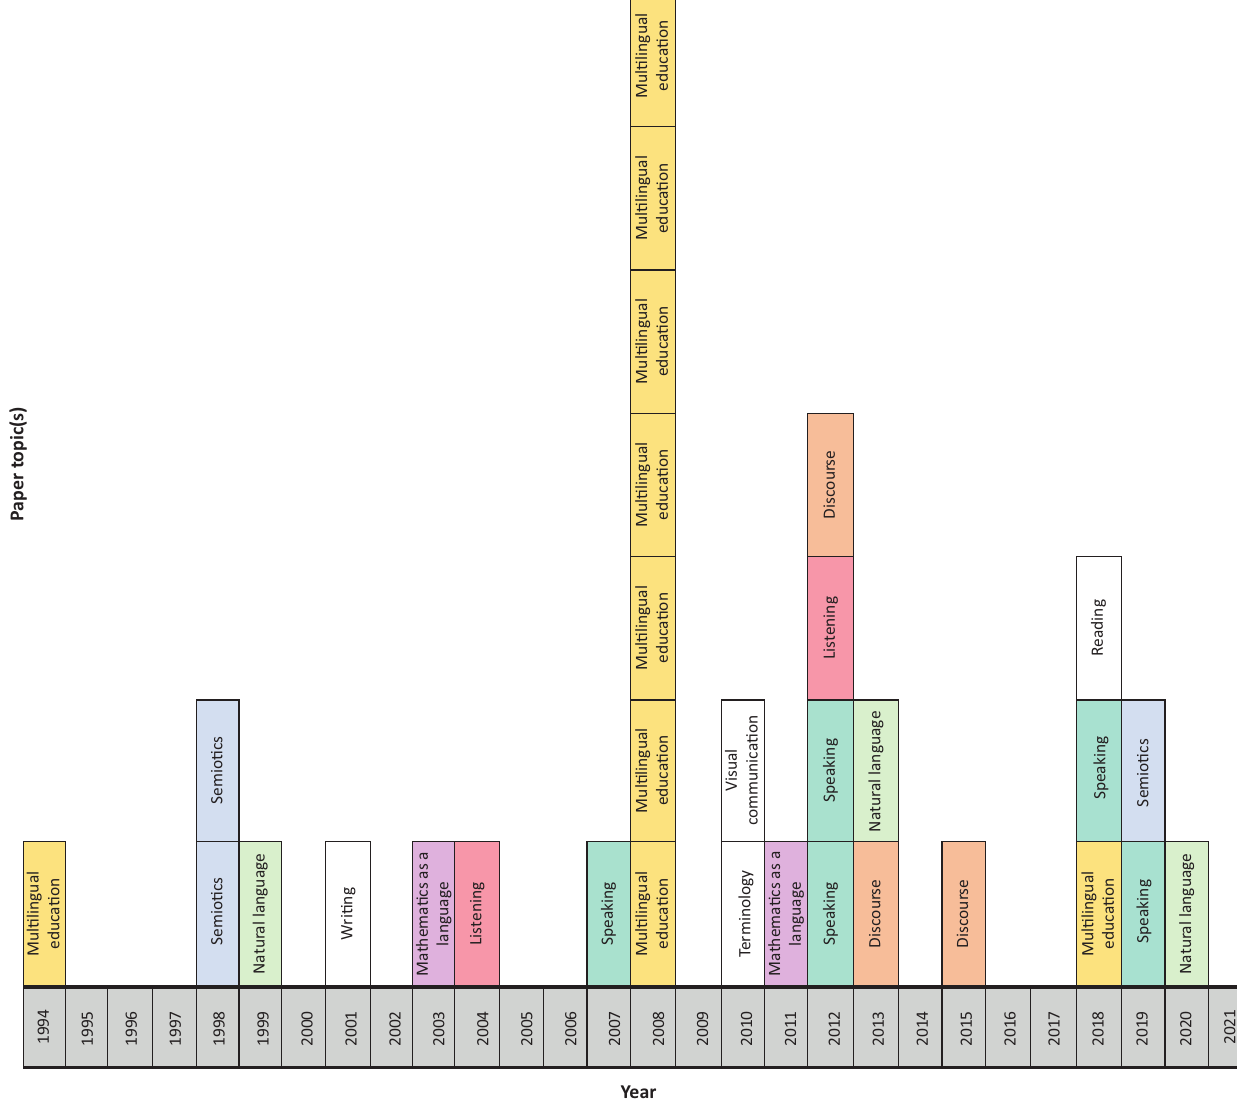
FIGURE 2: Paper topics per